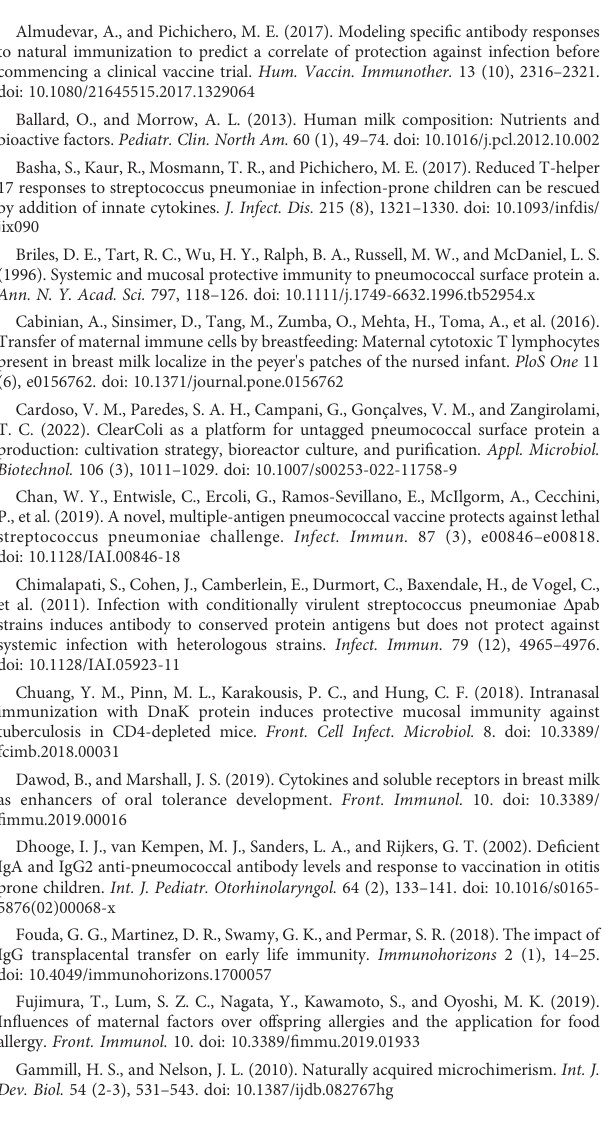
SUPPLEMENTARY FIGURE 1 Western blotting of serum of immunized mice. rPspA fi rstly electrophoresed in SDS-PAGE was transferred to a blot paper, then probed with 1:1,000 dilution of the pooled serum obtained from three mice immunized by rPspA. The band at the estimated size of rPspA (*) was con fi